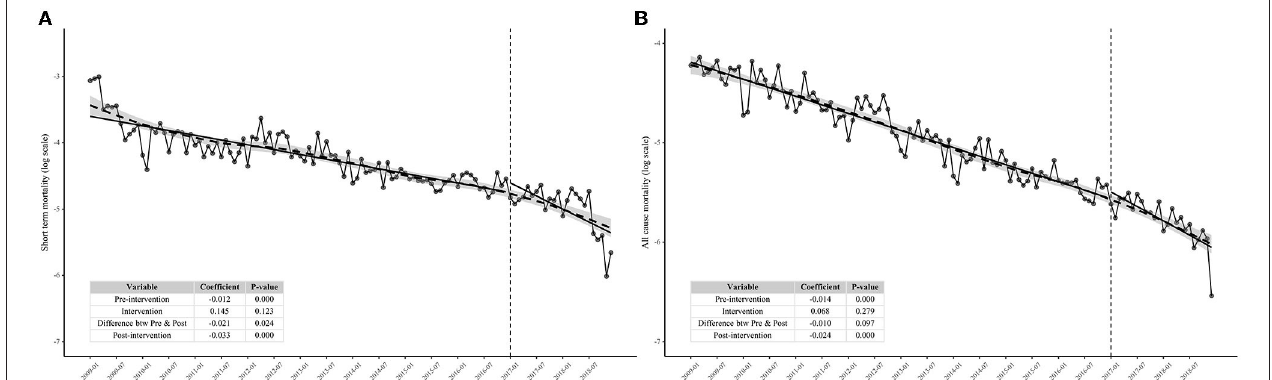
FIGURE 2 | Interrupted time series analysis showing the effect of test-and-immediate-treat policy on short-term mortality and all-cause mortality among people living with HIV in Guangdong Province from 2009 to 2018. (A) Effect of test-and-immediate-treat policy on short-term mortality and (B) effect of test-and-immediate-treat policy on all-cause